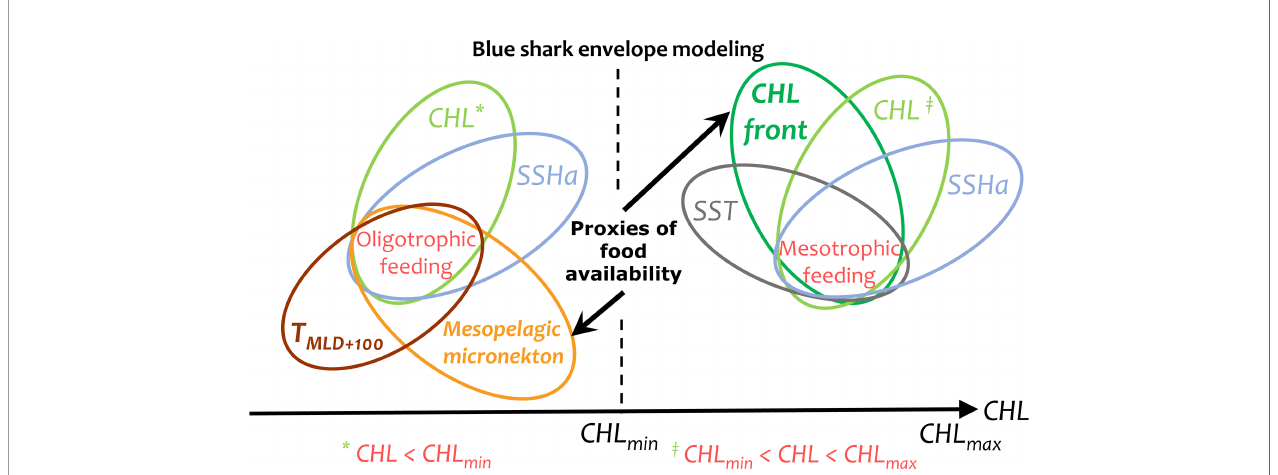
FIGURE 2 | Scheme of the blue shark envelope modeling linking the environmental variables in oligotrophic ( CHL < CHL min ) and mesotrophic ( CHL min < CHL < CHL max ) environments with mesopelagic micronekton and productivity fronts (chlorophyll-a horizontal gradients) as foraging proxies, respectively. The abiotic variables ( SST, T mld+100 and SSHa ) were used to exclude unsuitable environments. CHL , surface chlorophyll-a content; SST , sea surface temperature; T mld+100 , Temperature 100 m below the mixed layer depth; SSHa , sea surface height